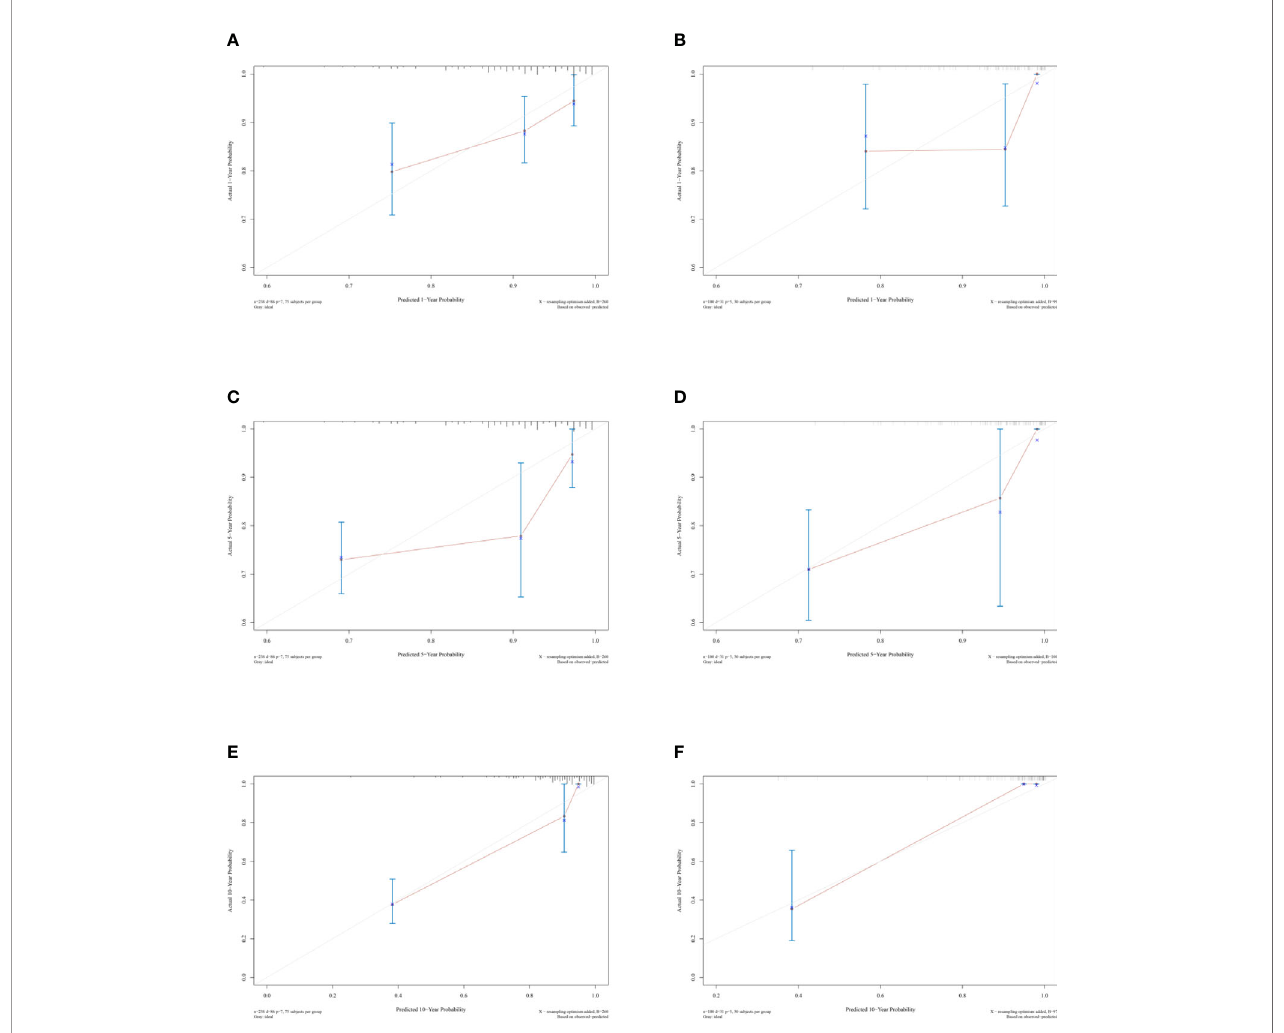
FIGURE 6 | Calibration curves of (A, C, and E) 1-, 5-, and 10-year DFS for training cohort. (B, D, and F) 1-, 5-, and 10-year DFS for validation